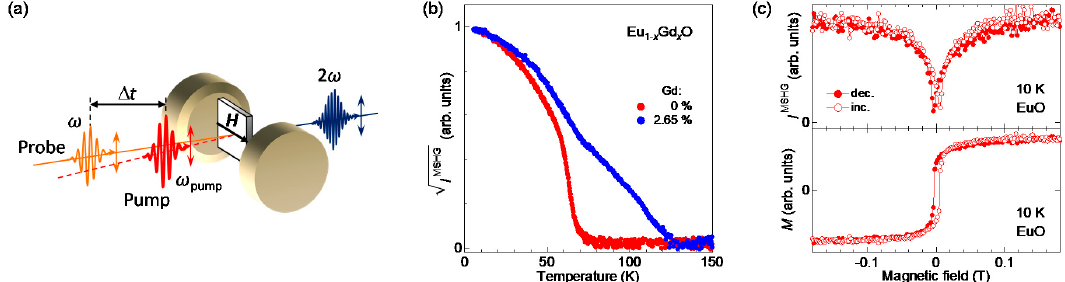
Figure 4. ( a ) Schematic representation of pump-probe nonlinear magneto-optical spectroscopy used in this study. The sample is excited by the pump pulse and the pump-induced changes in magnetic properties are detected by the probe pulse by using magnetization-induced second harmonic generation (MSHG). ( b ) Temperature dependence of the square root of the static MSHG intensity √𝐼 (cid:2897)(cid:2903)(cid:2892)(cid:2891) for undoped and 2.65% Gd-doped EuO (without pump irradiation). ( c ) The upper panel shows magnetic-field dependence of the MSHG intensity at 10 K in undoped EuO. Data represented by closed and open symbols were taken with decreasing and increasing fields, respectively. The lower panel shows magnetization curve extracted from the data in the upper panel.